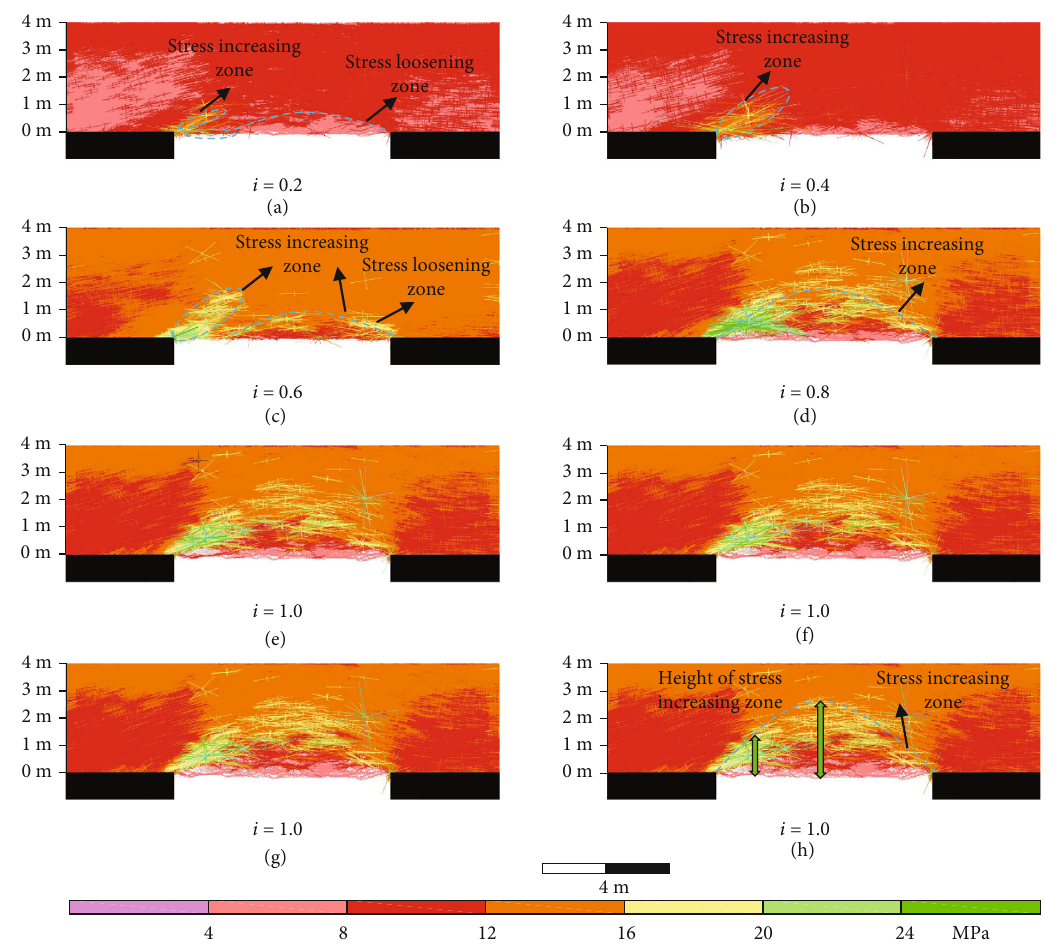
Figure 11: Cloud diagram of maximum principal stress under di ff erent stress release coe ffi cients.